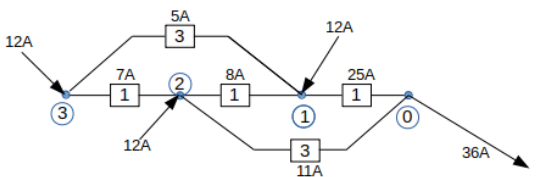
Figure 2. The network of Fig. 1 with input currents at multiple nodes (1, 2 and 3) and a single output at node 3. This is closer to an egress scenario.